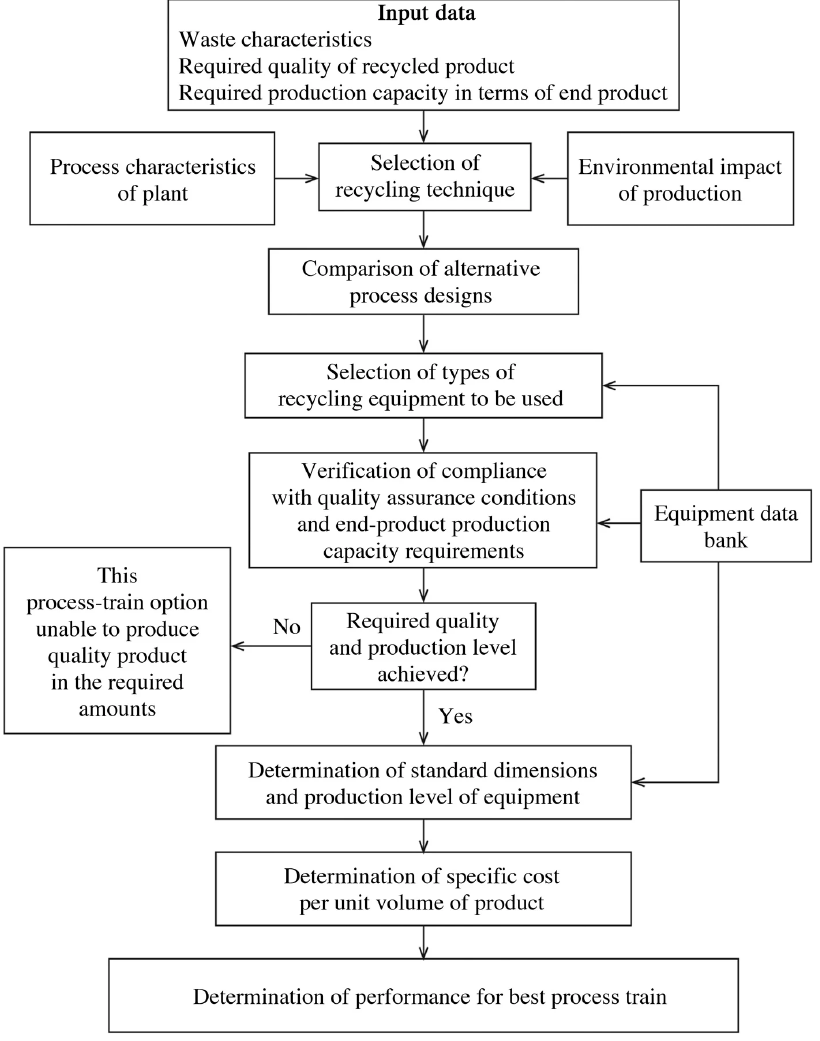
Figure 4. Flow chart for mineral waste recycling process-train design algorithm. Source: [113]. Re-used with permission from Springer Nature (5342261298332).